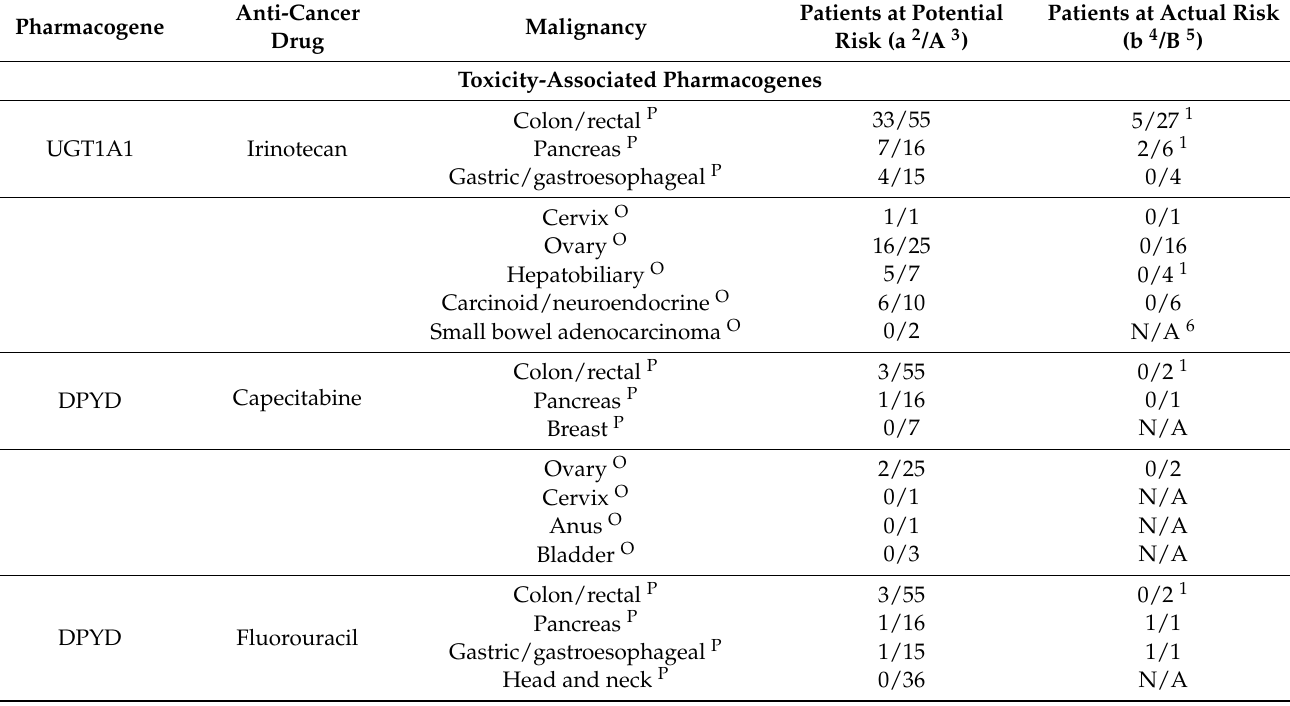
Table 3. Pharmacogenes and their clinical relevance to cancer patients. Clinical Pharmacogenetics Implementation Consortium (CPIC) level A pharmacogenes are listed with their associated anti-cancer drugs and associated malignancies as per National Comprehensive Cancer Network (NCCN) guidelines. Patients at potential risk indicates patients with any disease-relevant pharmacogenomic variants for each specified malignancy regardless of treatment received. Numerator indicates patients with variant alleles and denominator includes all patients with specified malignancy. In other words, of the 55 patients with colon/rectal cancer, 33 had UGT1A1 variants. Patients at actual risk indicates patients with variant alleles for each associated malignancy who were treated with associated anti-cancer drugs at our institution. Numerator indicates patients treated with specified drug and denominator includes all patients with specified malignancy with associated variant allele. In other words, of the 55 patients with colon/rectal cancer, 27 patients had a UGT1A1 variant and were treated at our institution; five of those patients received